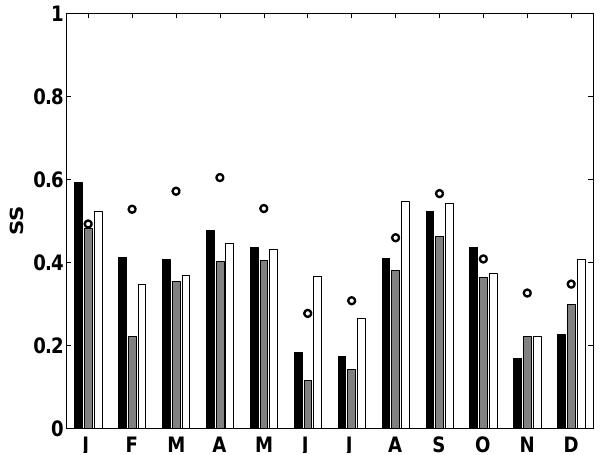
Figure 6. Values of SS for AWS1 (black), AWS2 (gray), and AWS3 (white) for the predictor rea-ens-air for period 1. The open circles show the respective values of SS at AWS1 for its entire data period (period 2).